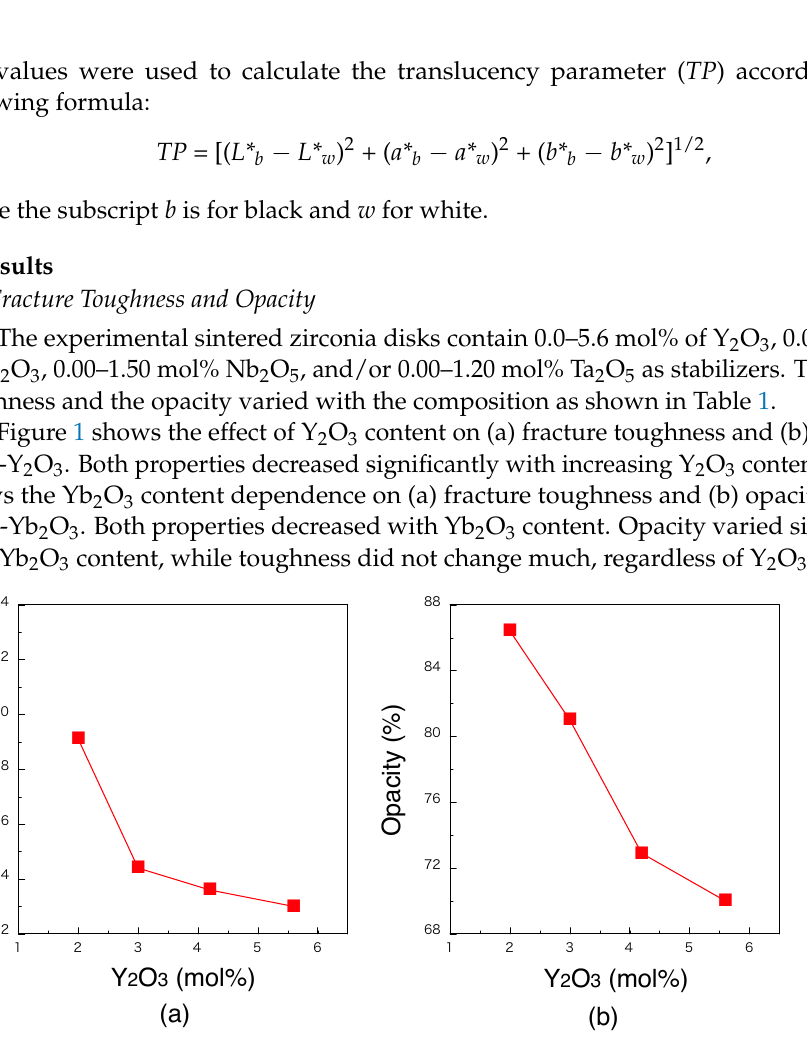
Figure 1. The effect of Y 2 O 3 content on ( a ) fracture toughness and ( b ) opacity of ZrO 2 -Y 2 O 3 (No. 1–4).